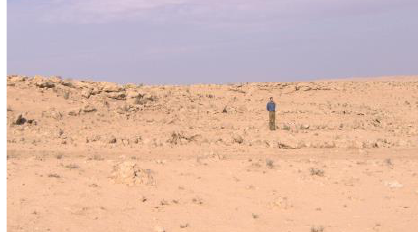
Figure 16. Corrals surveyed on the ground. Photo: M. Lönnqvist (present Silver) 2009.